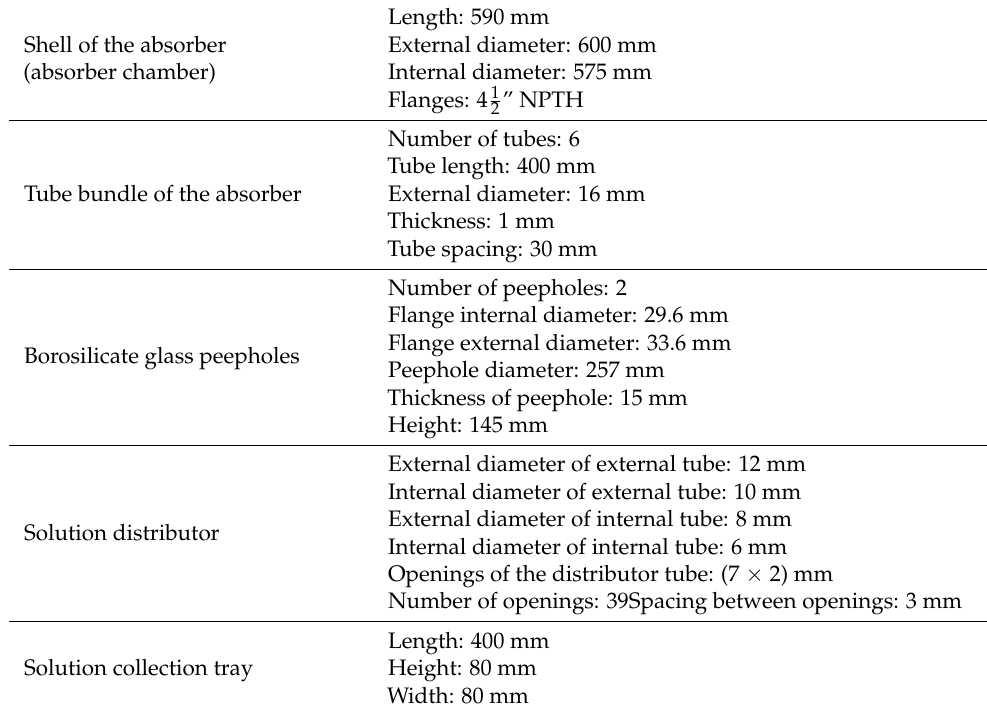
Table 1. Geometrical parameters of the different components in the absorber.